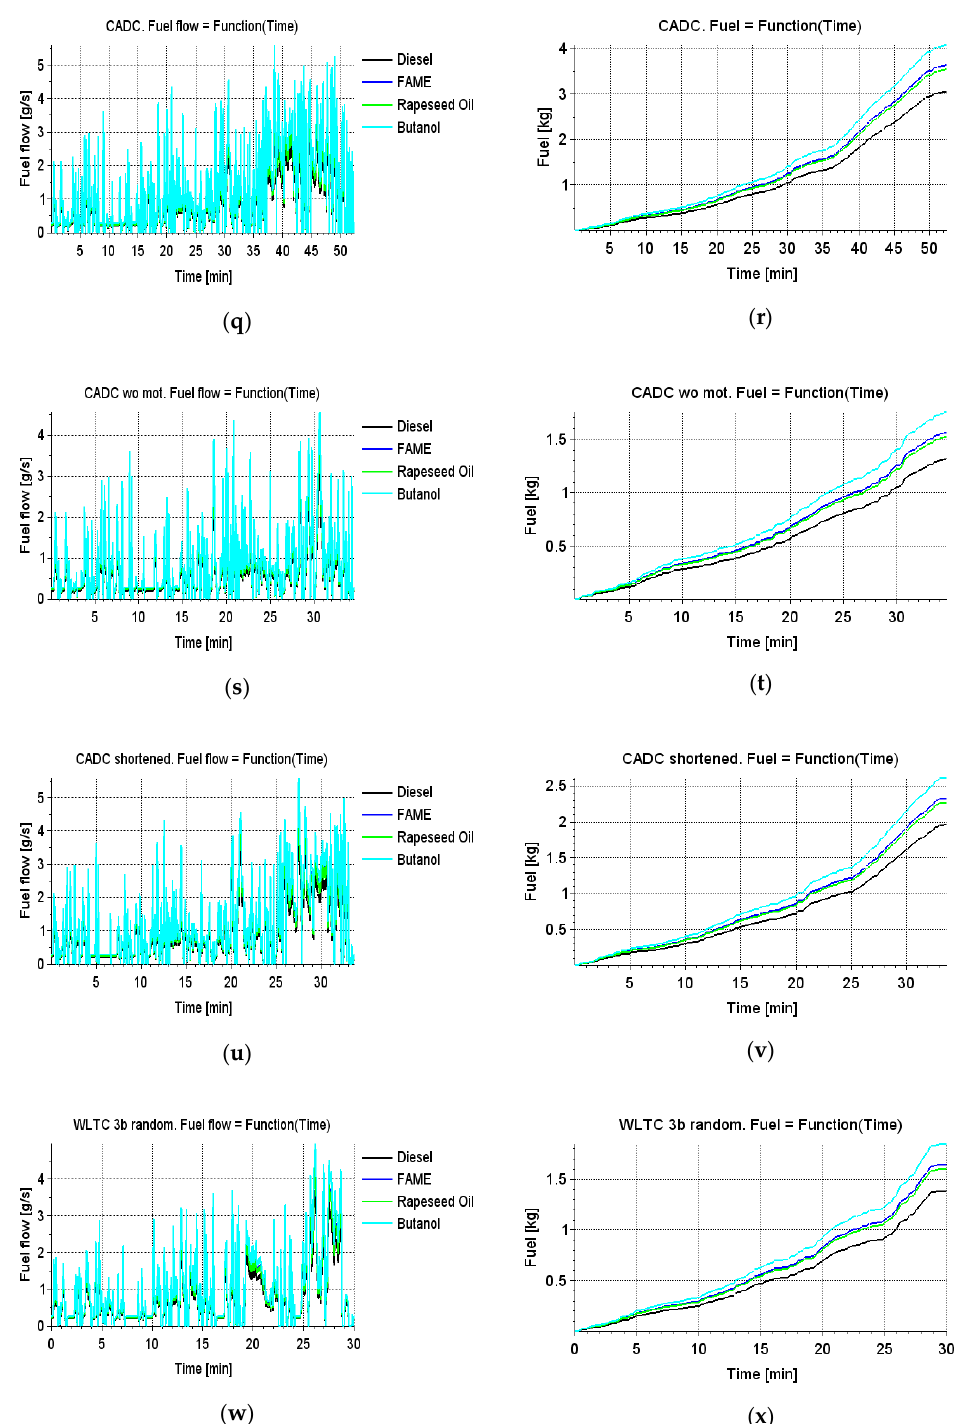
Figure 10. Results of the simulation of the stream and final fuel consumption for selected driving tests and selected fuels for the 2013 Mercedes E350 vehicle: ( a ) Waveforms of the instantaneous values of the fuel stream powering the vehicle’s engine, obtained in the simulation of the US 06 road test; ( b ) Waveforms of the instantaneous values of fuel consumption for the vehicle, obtained in the simulation of the US 06 road test; ( c ) Waveforms of the instantaneous values of the fuel stream powering the vehicle’s engine, obtained in the simulation of the US highway road test; ( d ) Waveforms of the instantaneous values fuel consumption values for the vehicle, obtained in the US highway test simulation; ( e ) Waveforms of the instantaneous values of the fuel stream powering the vehicle’s engine, obtained in the simulation of the FTP 75 road test; ( f ) Waveforms of the instantaneous values of fuel consumption for the vehicle, obtained in the simulation of the FTP 75